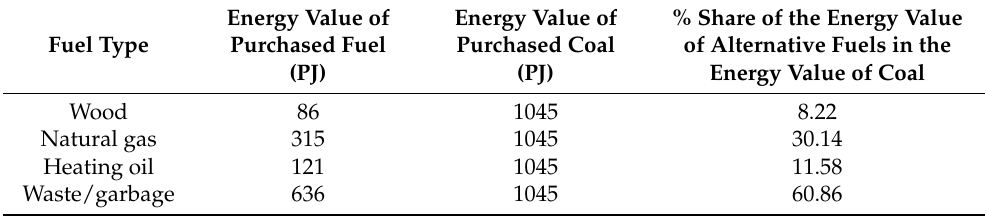
Table 6. Estimation of the share of the energy value of alternative fuels compared to the energy value of coal, assuming that the entire cash flow is allocated to the purchase of only one energy fuel (scenarios